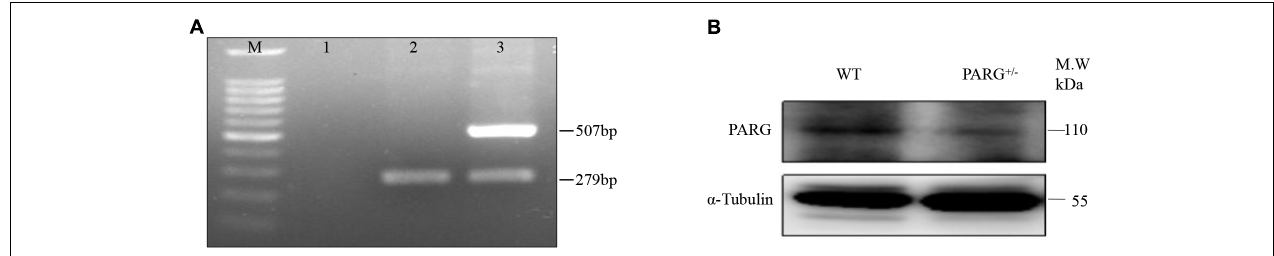
FIGURE 1 | Genotyping of poly (ADP-Ribose) glycohydrolase (PARG) knockout mice. Genotyping of PARG + / − mice. (A) Genotyping by PCR. Lane M, 100 bp DNA Marker; Lane 1, blank control; Lane 2, WT mice; and Lane 3, PARG + / − mice. (B) Genotyping by Western blotting. The expression of PARG 110 protein was assessed in lungs from WT and PARG + / −